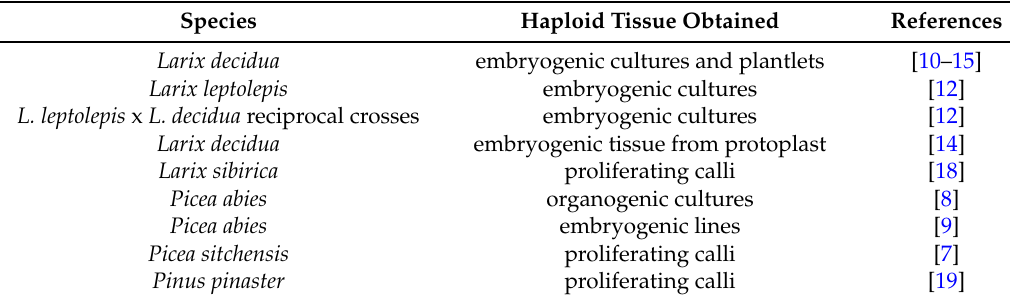
Table 1. Haploid tissue obtained from megagametophyte cultures of conifer species. Species Haploid Tissue